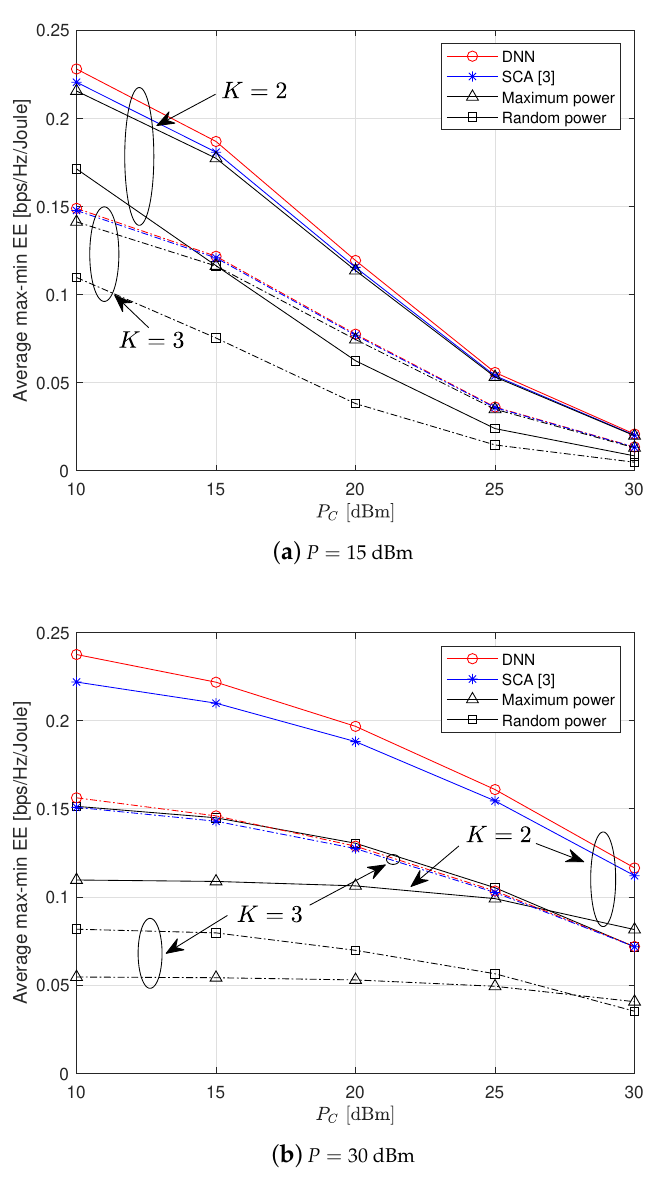
Figure 10. Average max-min EE performance as a function of P C for K = 2 and